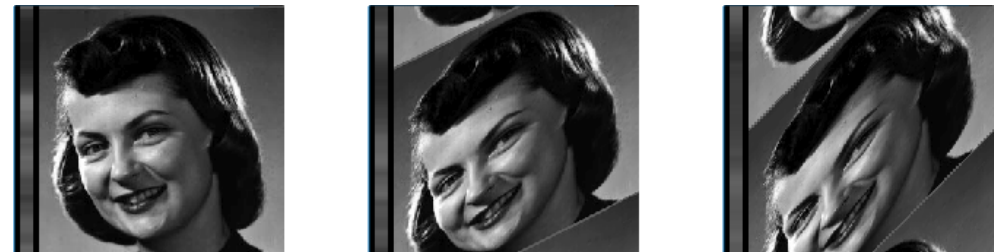
Figure 4. From left to right, an image, sheared to accommodate, in a row, the discrete lines of central DRT for minimal, intermediate, and maximal slope of the 0 to 45 degrees